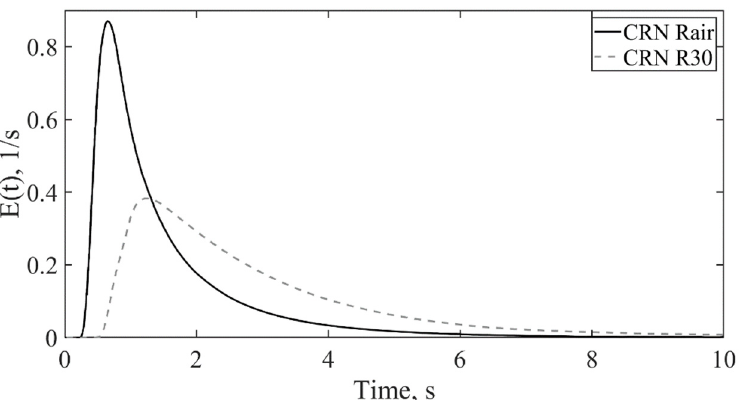
Figure 7. Comparison between the CRN-fit for Rair and R30.